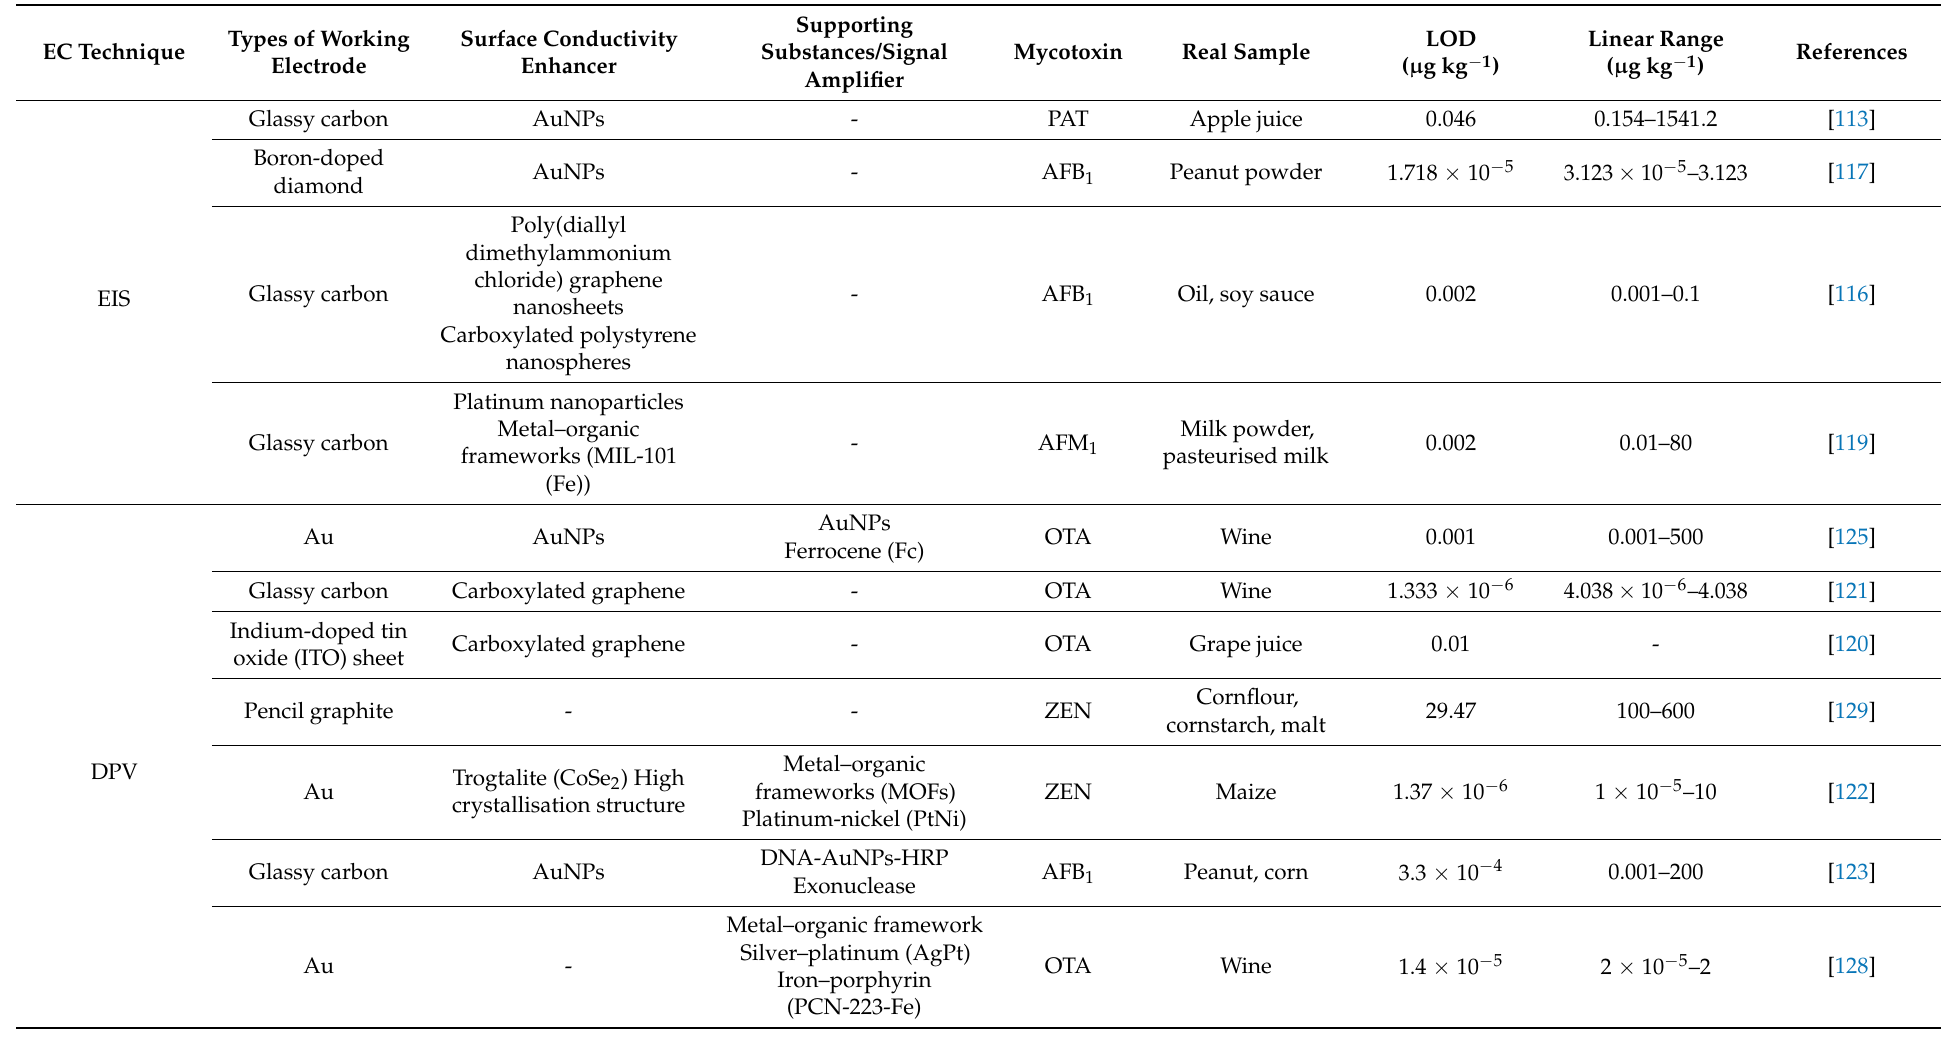
Table 5. Comparison of aptasensor performance by the EC techniques and the materials used at the electrode surface for signal amplification.